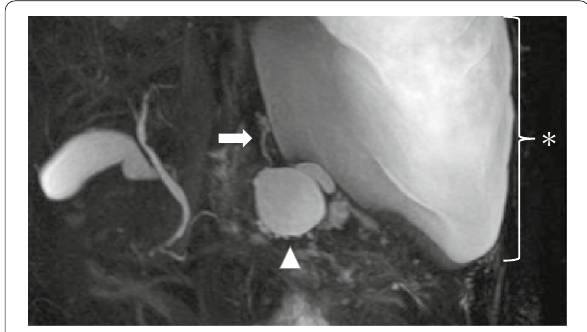
Fig. 2 Findings of magnetic resonance cholangiopancreatography (MRCP). MRCP shows a fistula (arrow) from the pseudocyst (arrowhead) into the thoracic cavity